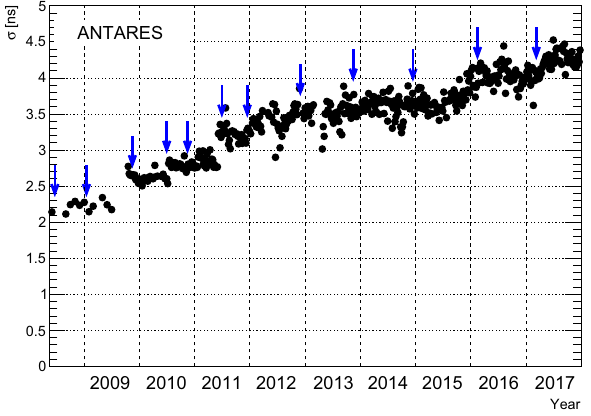
Fig. 7 Standarddeviation, σ ,oftheaveragetimeoffsetasafunctionof time. The blue arrows indicate the periods in which high voltage tuning of the PMTs has been performed